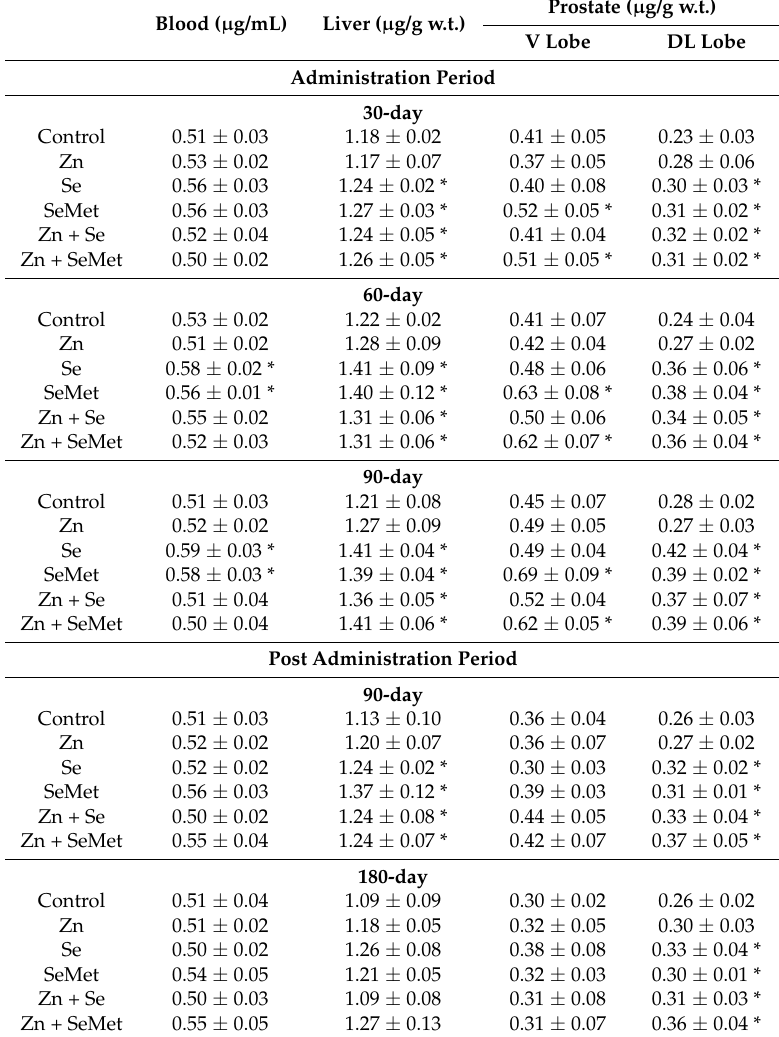
Table 2. Selenium level in the blood, liver and prostate of rats following zinc gluconate (Zn), sodium selenite (Se) and selenomethionine (SeMet) administration given jointly or separately for 30, 60 and 90 days and then after 90 and 180 days post